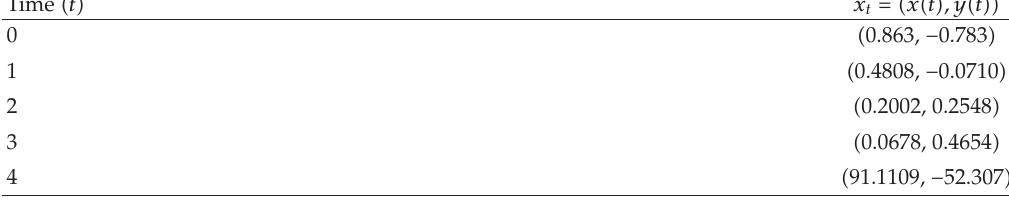
Table 1: Coordinates of the intersection of the level curves t (cid:5) 0 , 1 , 2 , 3 , 4.